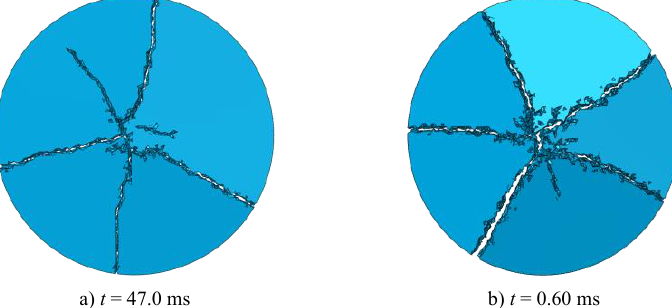
Fig. 14 Glass fragmentation (bottom view) for ring-on-ring test simulation with the immediate element failure model for target piston velocities of a) 10 mm/s, and b) 1000